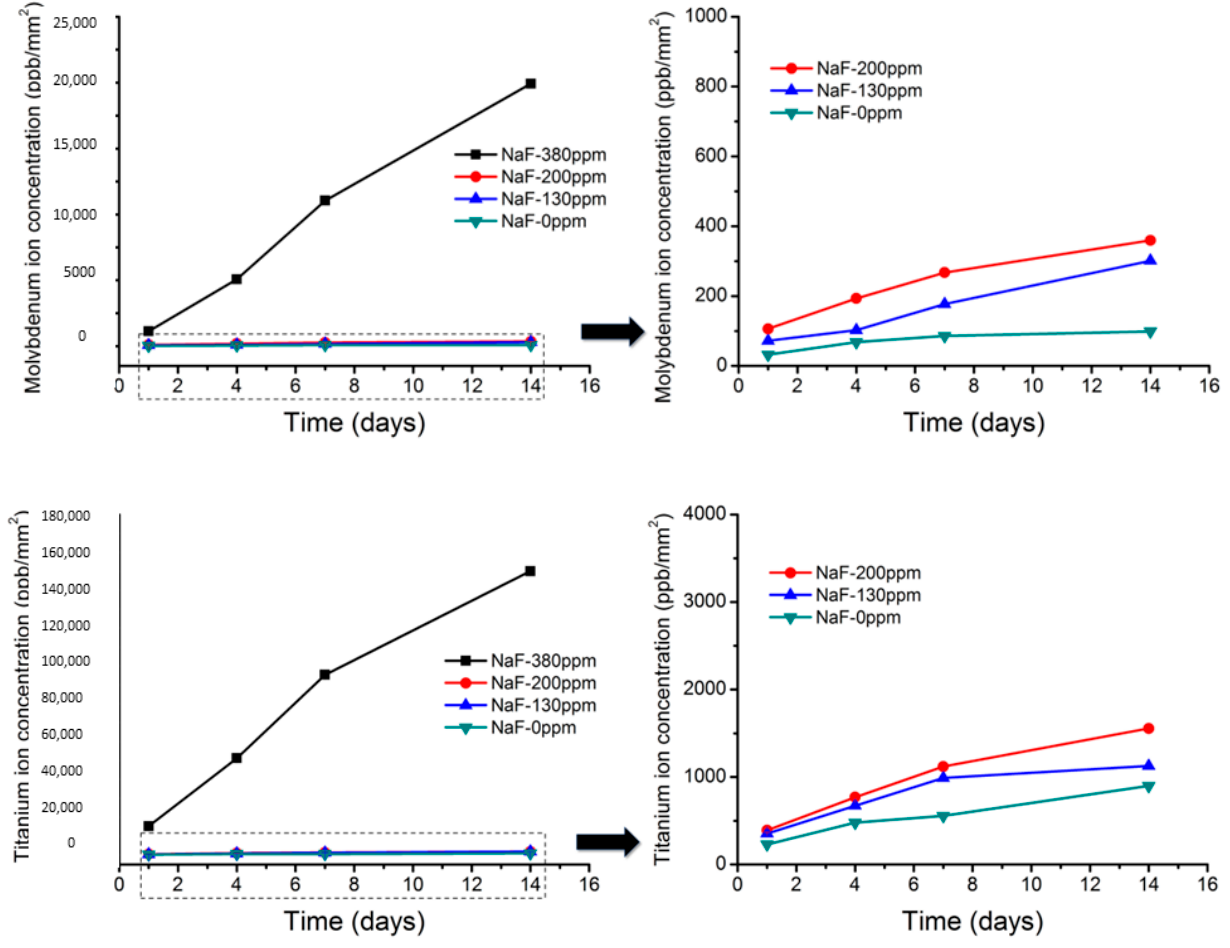
Figure 4. Titanium and molybdenum ion release at different times of immersion and at different fluo- ride concentrations solutions. At concentrations of 130 and 200 ppm, the figure has been magnified. The contact surface of the archwire with the solution is 100 mm 2